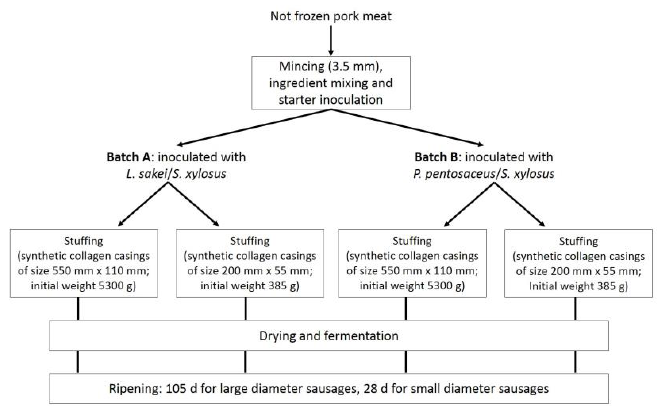
Figure 1. Process scheme of the manufacturing of the Milano sausages produced with the two starter cultures.